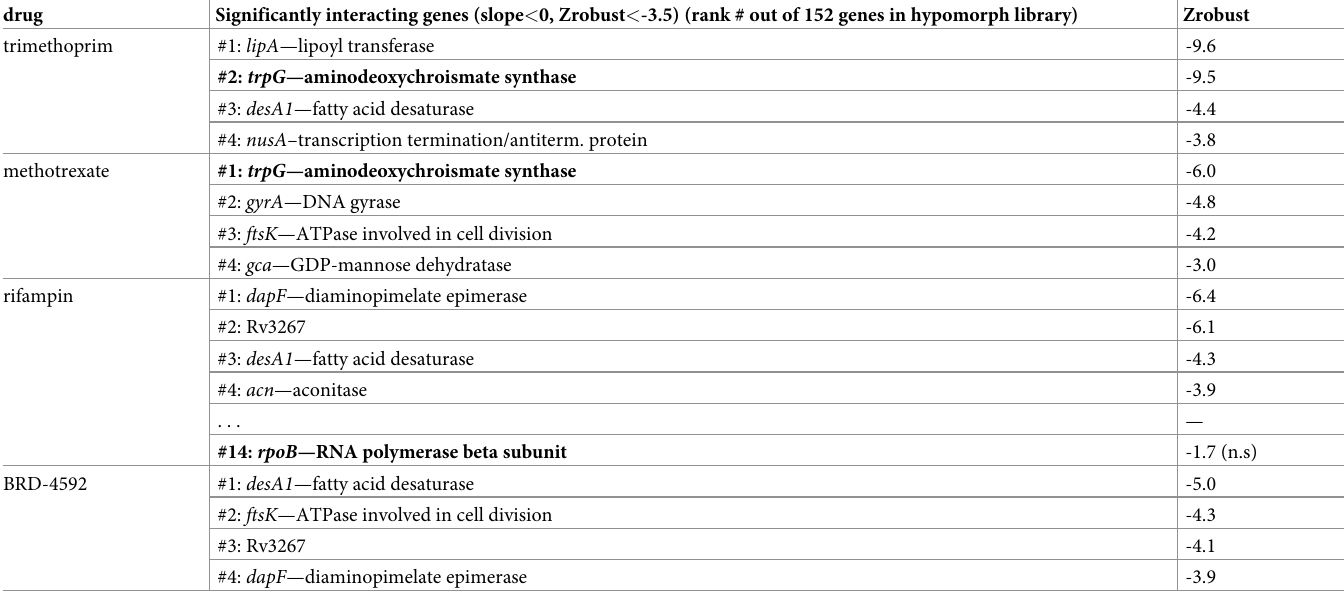
Out of a library of 155 genes, there were 4 genes with outlier negative slopes for each drug. Genes relevant to the mechanism of resistance are bold-faced. Note that